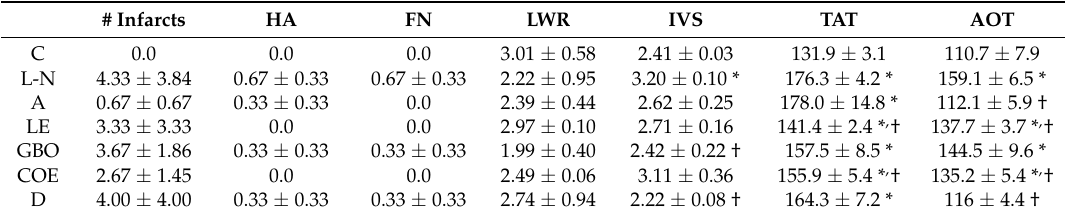
Table 4. Histopathological results of the heart and aorta.